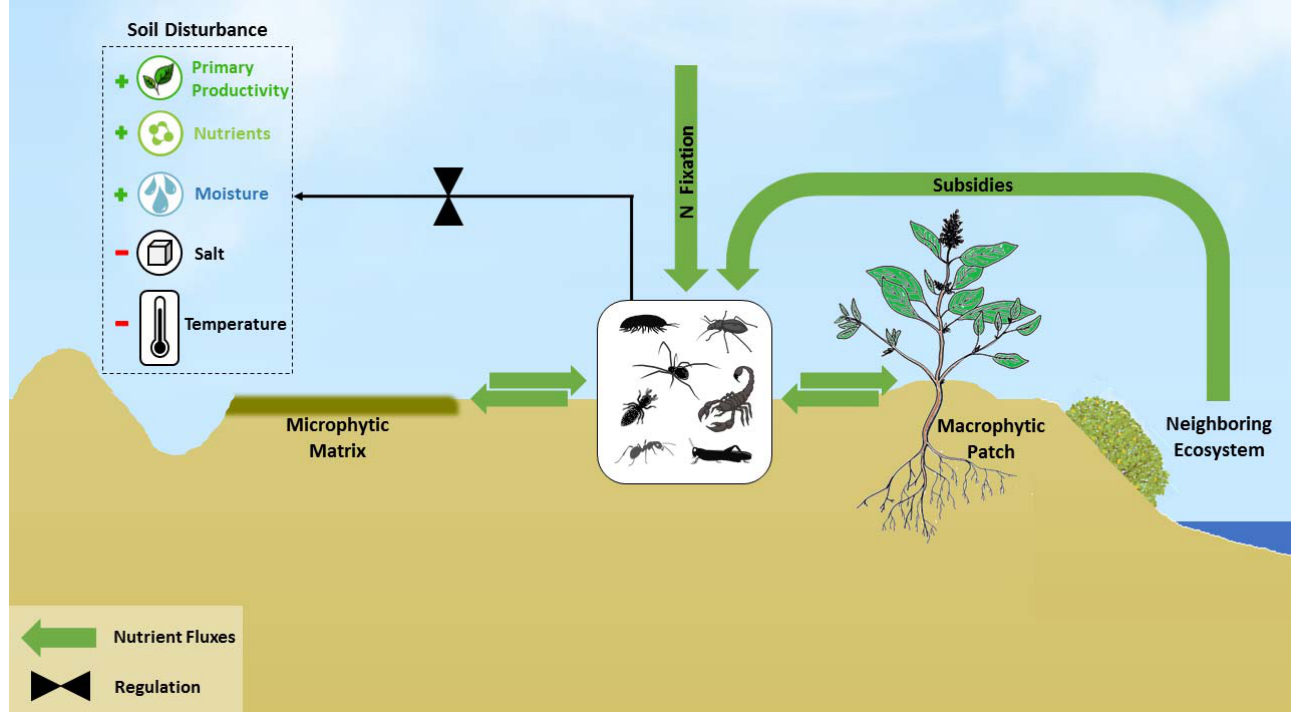
Figure 2. Pathways by which arthropods affect desert nutrient dynamics: arthropods transport nutrients between macrophytic patches and microphytic matrix, import nutrients from more productive neighboring ecosystems, and create soil disturbances that accumulate water and nutrients and provide favorable abiotic conditions for primary producers. Arthropods hosting diazotrophic bacteria in their gut can fix atmospheric N, resulting in soil N enrichment and enhanced N cycling.